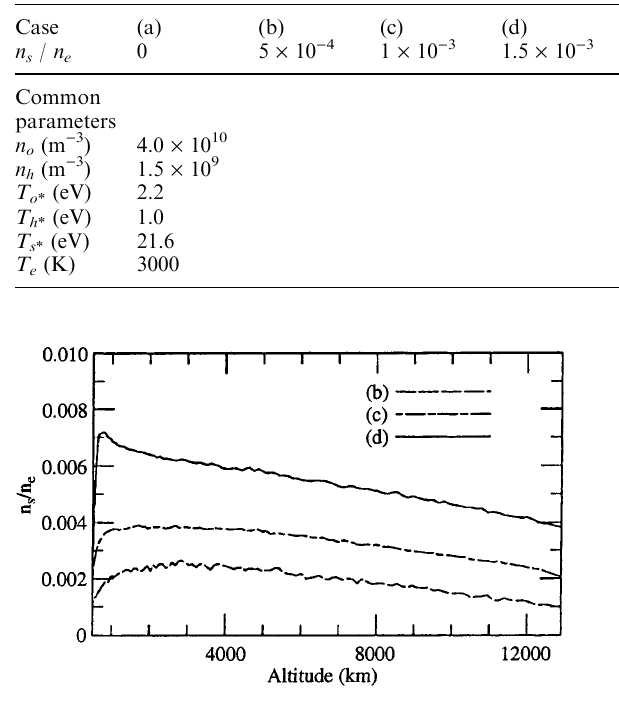
Fig. 9. Profiles of relative photoelectron density. The labels correspond to the cases listed in Table 3